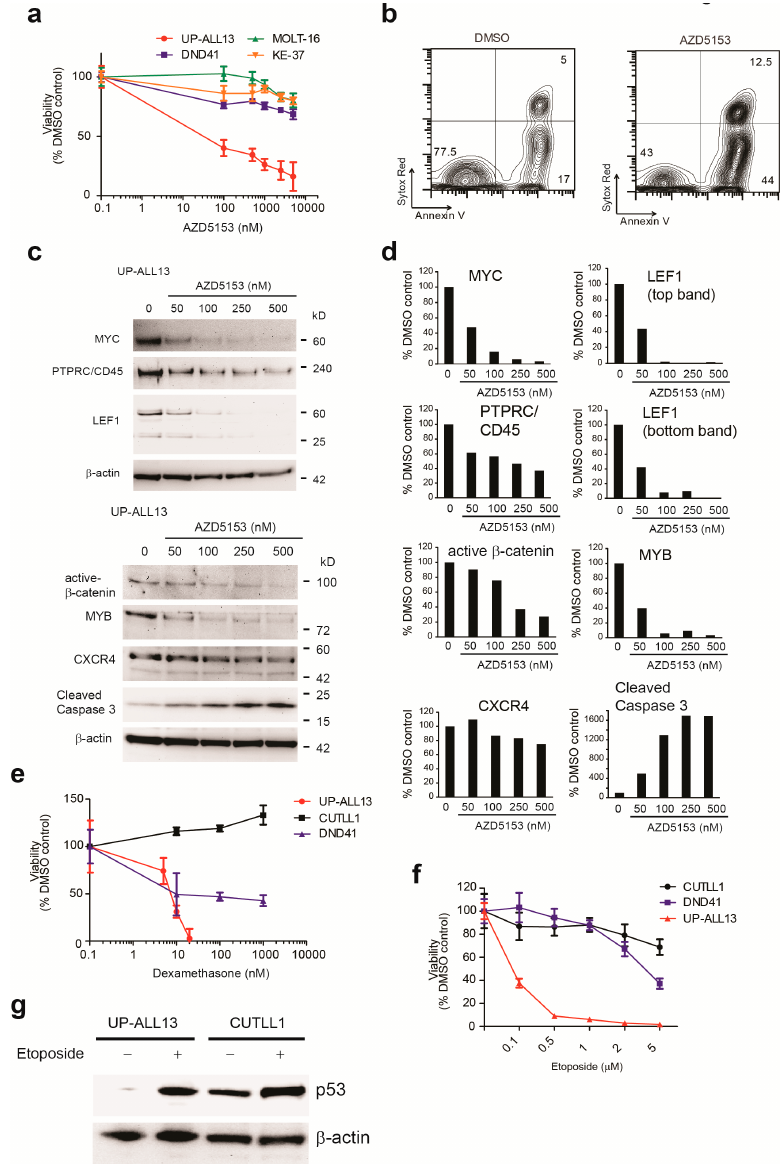
Figure 5. Therapeutic response of UP-ALL13 to the Bromodomain-containing protein 4 (BRD4) inhibitor AZD5153 and other chemotherapeutic drugs. ( a ) Effect of BRD4 inhibition on the viability of UP-ALL13 and the T-ALL cell lines CUTLL1, DND41, MOLT-16, and SKW3/KE-37. Viability was evaluated after 24 h of incubation with increasing doses of AZD5153. ( b ) Representative plots of apoptosis in UP-ALL13 cells treated in vitro with vehicle or AZD5153 (100 nM) for 24 h. ( c ) Western blot analysis of MYC, active β − catenin, CXCR4, CD45/PTPRC, MYB, and LEF1 in UP-ALL13 cells treated in